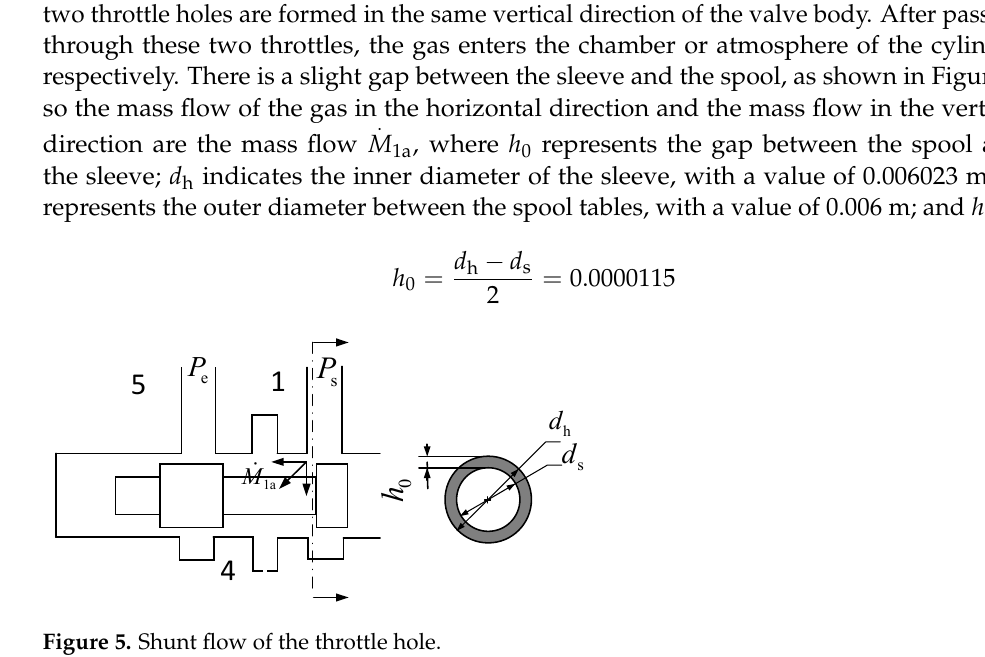
d indicates the inner s h d represents the outer diameter be- s h is: 0